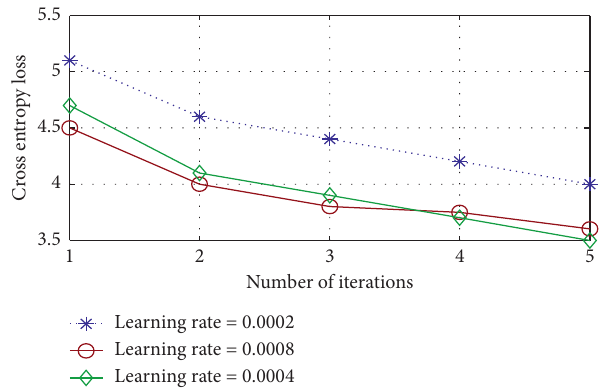
Figure 8: Comparison of cross-entropy loss under different learning